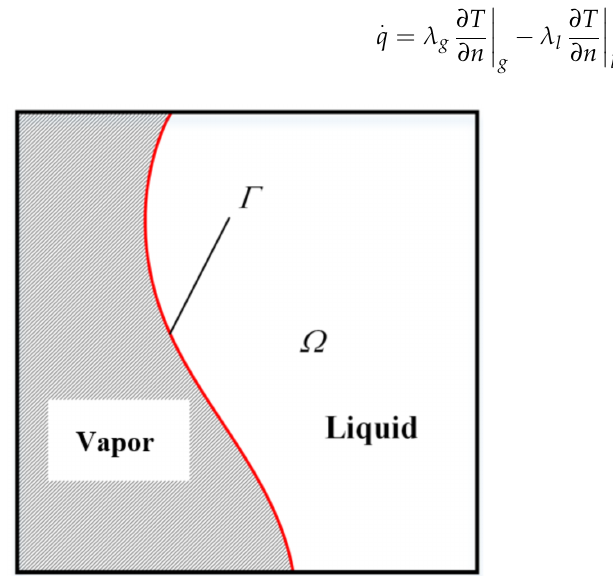
Figure 1. Schematic of a cell with a phase